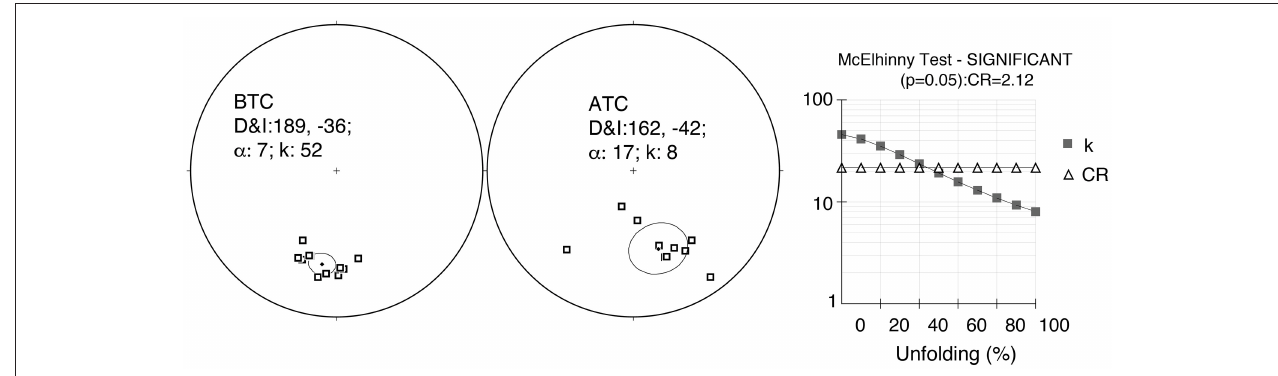
FIGURE 8 | McElhinny’s fold test for the characteristic component in the sampled rocks. Equal-area projections are before (BTC) and after (ATC) tectonic correction. The fold test is significant and negative. The CR (CR: critical value) depends on the number of samples and their vectorial sum. The test is positive when k > CR and maximum at 100% unfolding, and it is negative when k > CR and maximum at 0% unfolding of the bedding planes.